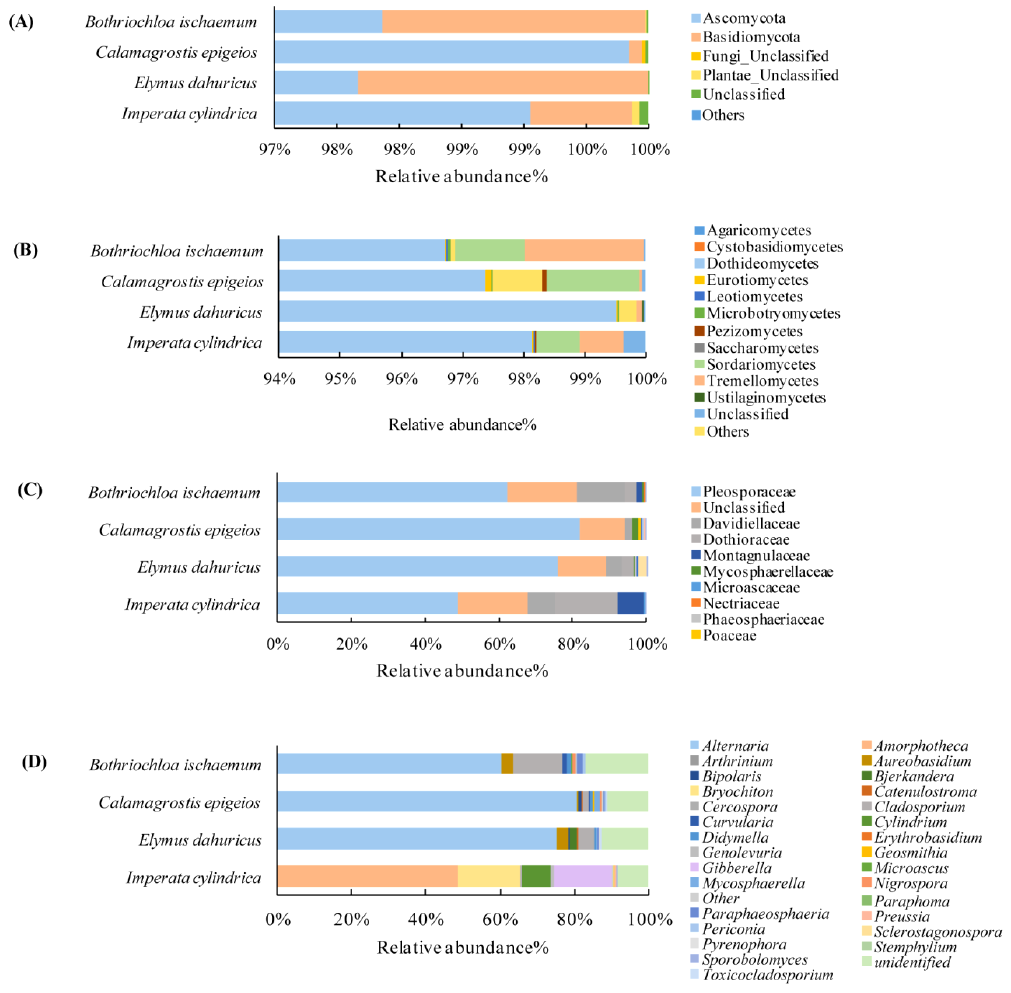
Figure 3. Relative abundance of four native grasses phyllosphere fungi communities at the levels of phylum ( A ), class ( B ) and greater than 0.1% at family ( C ) and genus ( D ) levels.